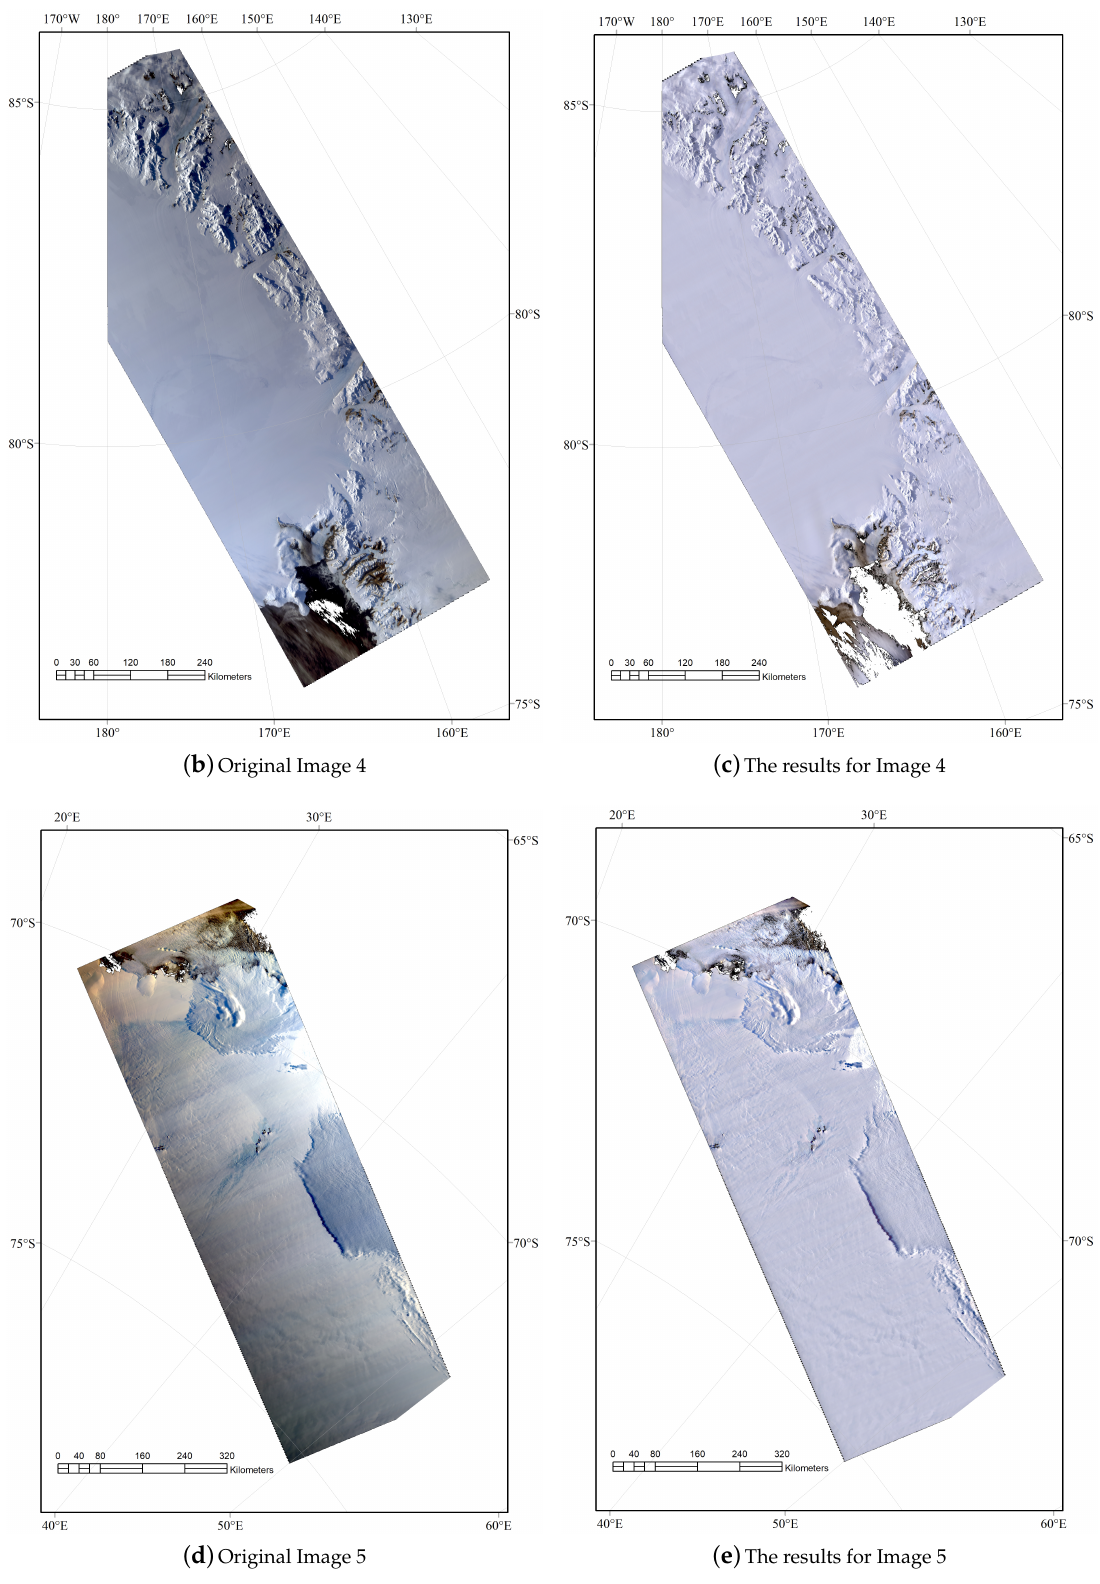
Figure 9. Comparisons between the original images and the result of the single-view color consistency